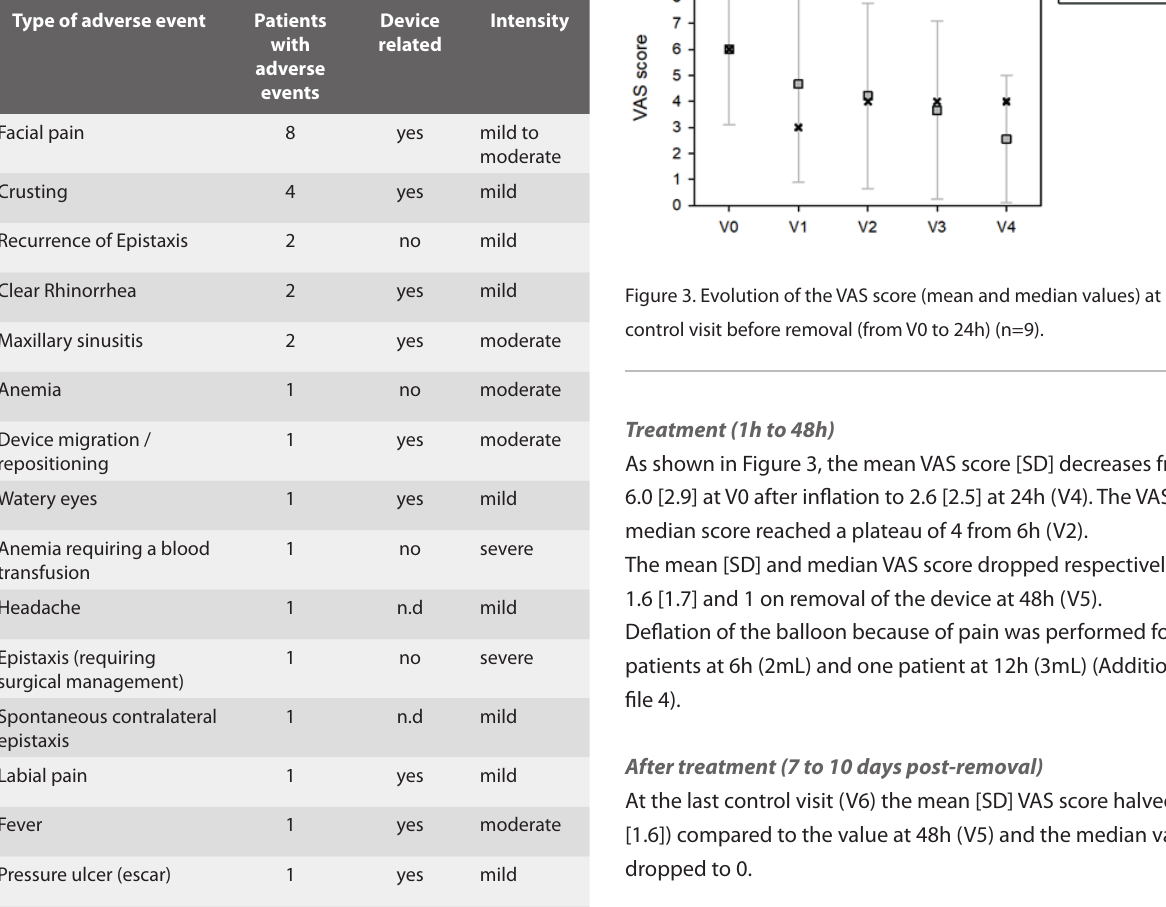
Table 2. Number and % of patients per type of adverse events.